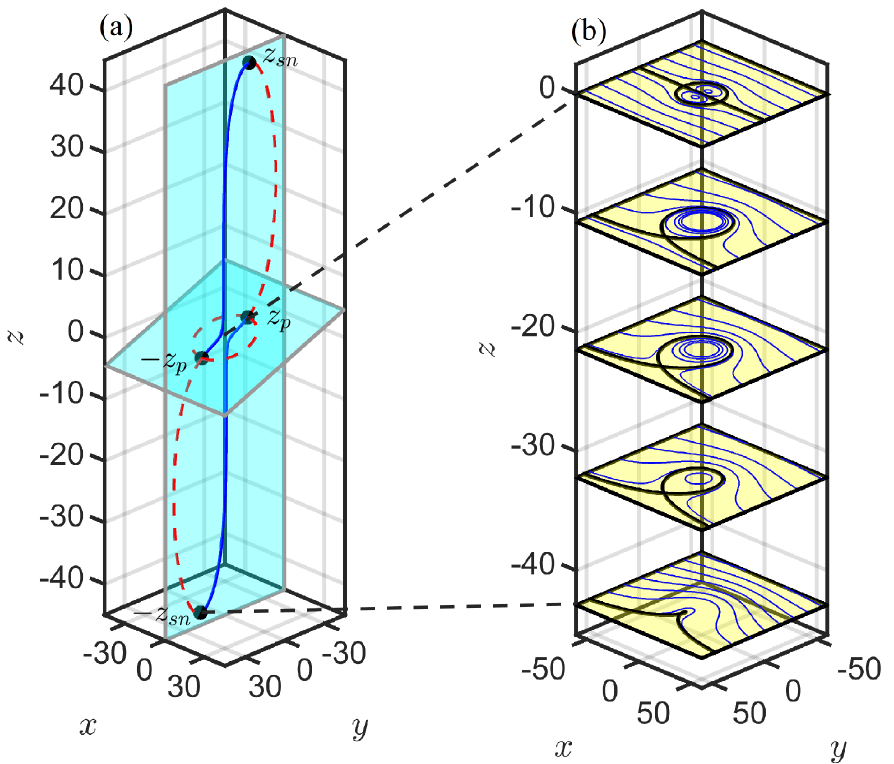
Figure 6. Same as Figure 5 but for Z = 10. Panel ( a ) illustrates the generation/destruction of stable (solid blue curves) and unstable (dashed red curves) fixed points. The saddle-node bifurcation is now at z = − z sn ≈ − 42.96. The pitchfork bifurcation remains at z = − z p = panel ( b ) illustrate the three-dimensional volume trapped by the heton at five equally spaced planes between z = − 42.96 and z =